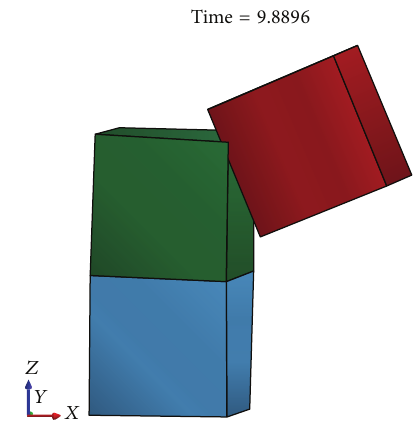
Figure 4: Block impact under full contact conditions (9.8